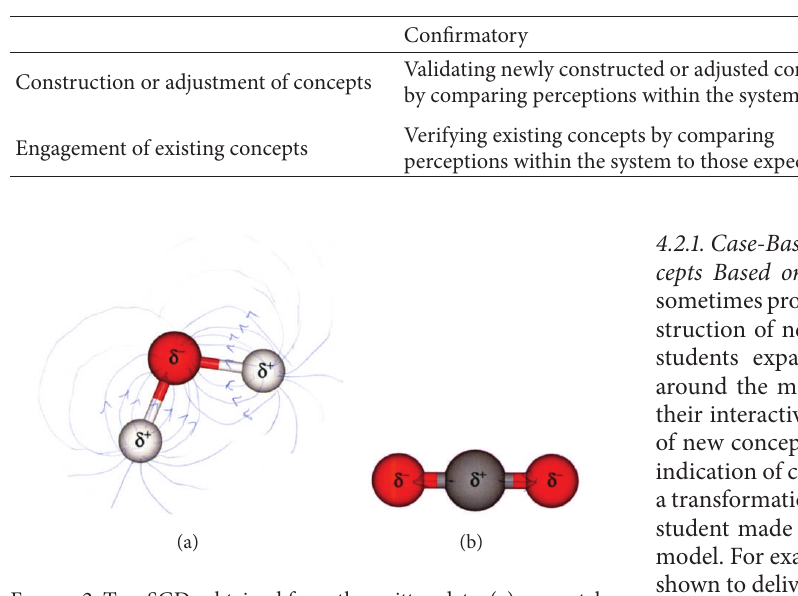
Table 1: Intersections of students’ deployment of conceptual knowledge (construction or adjustment of concepts/engagement of existing concepts) with emergent interactive strategies (confirmatory/exploratory) observed in think-aloud tasks with a visuohaptic virtual model of molecular electric fields.